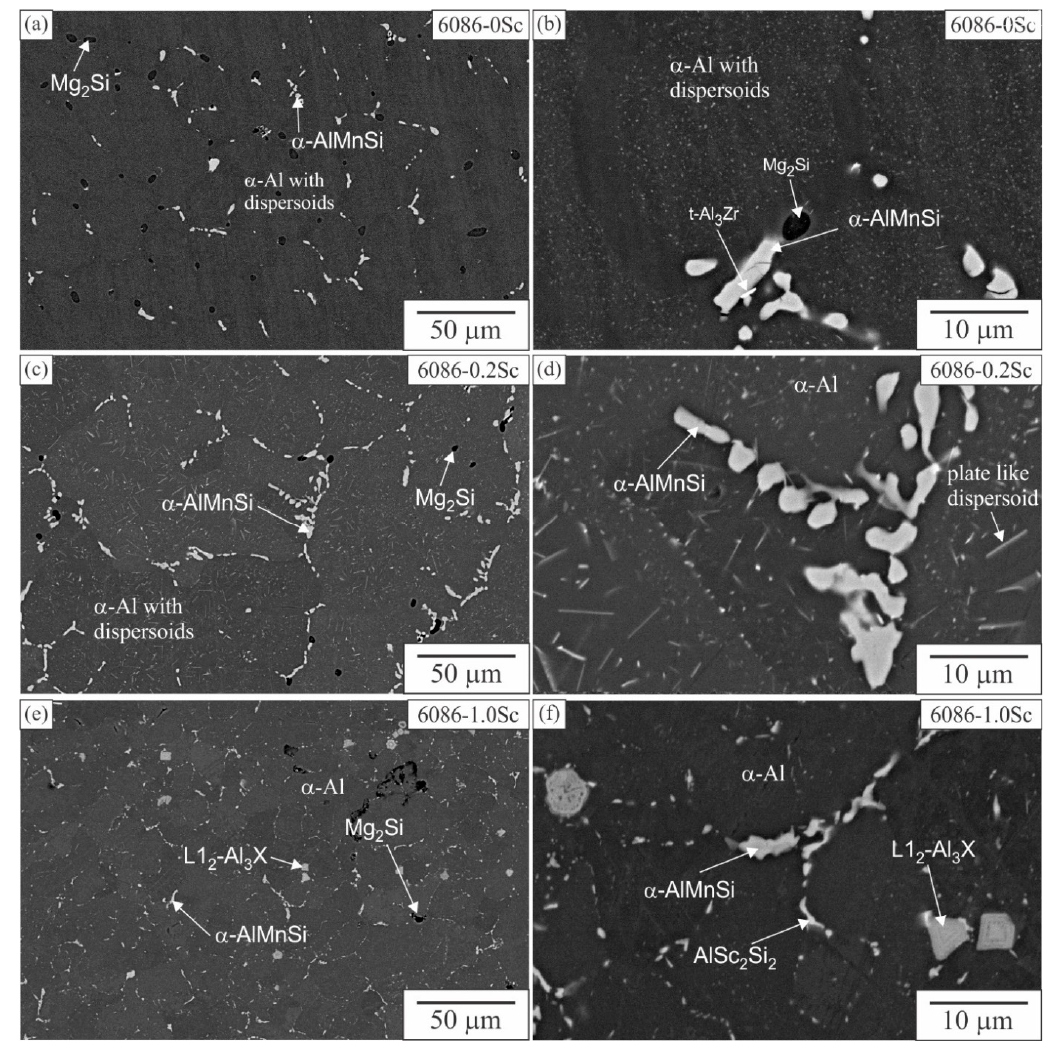
Figure 10. BSE electron micrographs of the investigated alloys after homogenisation at 520 °C for 40 h. The alloy 6086-0Sc at ( a ) a lower and ( b ) a higher magnification; the alloy 6086-0.2Sc at ( c ) a lower and ( d ) a higher magnification and the alloy 6086-1Sc at ( e ) a lower and ( f ) a higher magnification.